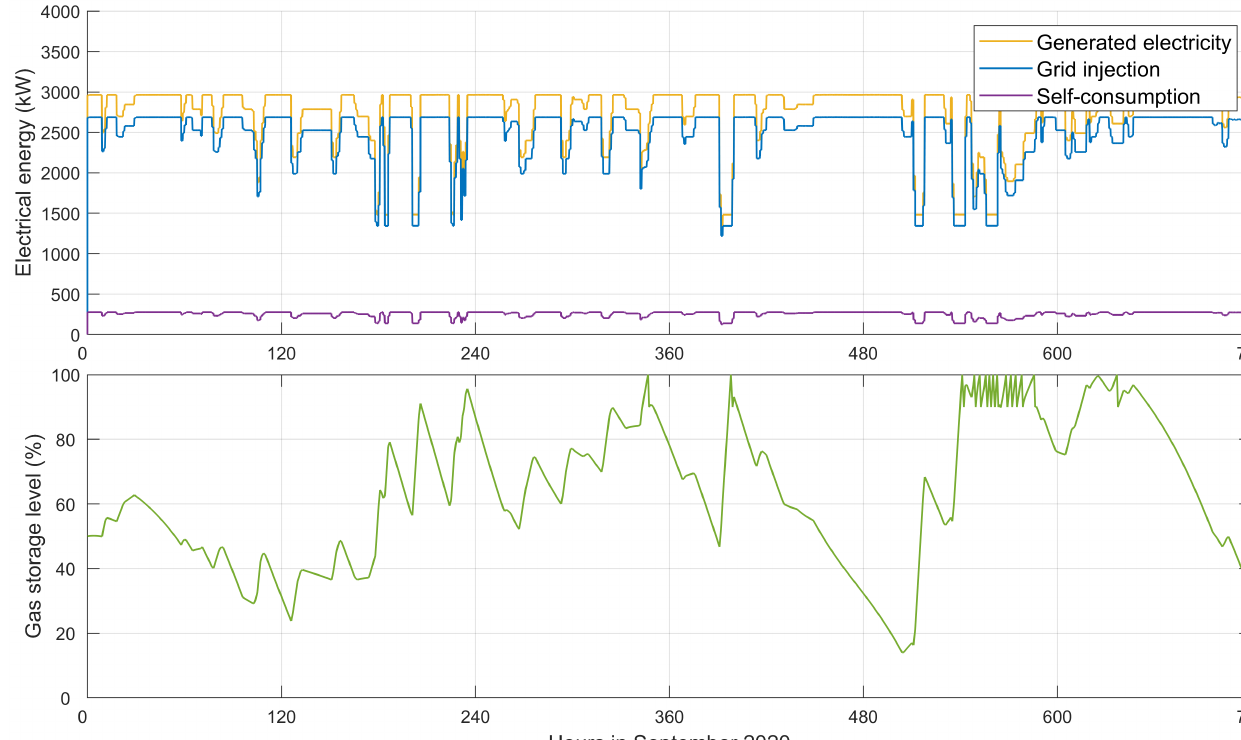
Figure 8. Upper plot: real electrical output (yellow), simulated grid injection (blue) and simulated self-consumption of the biogas plant (purple); lower plot: gas storage level evolution throughout September